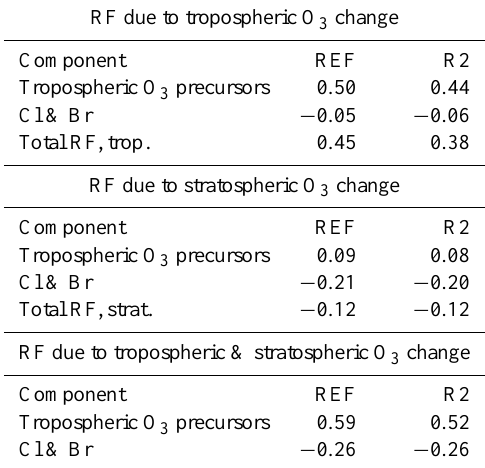
Table 6. The different components of the radiative forcing due to the change in O 3 since the pre-industrial